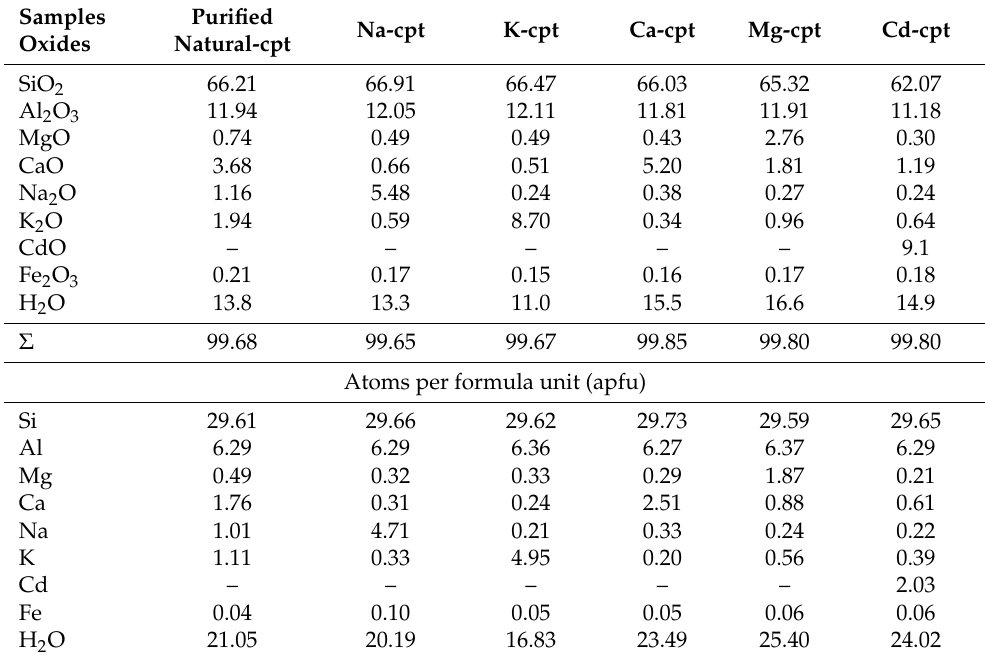
Table 1. Chemical composition (EDS, wt%) and structural formula of clinoptilolite based on 72 O atoms.